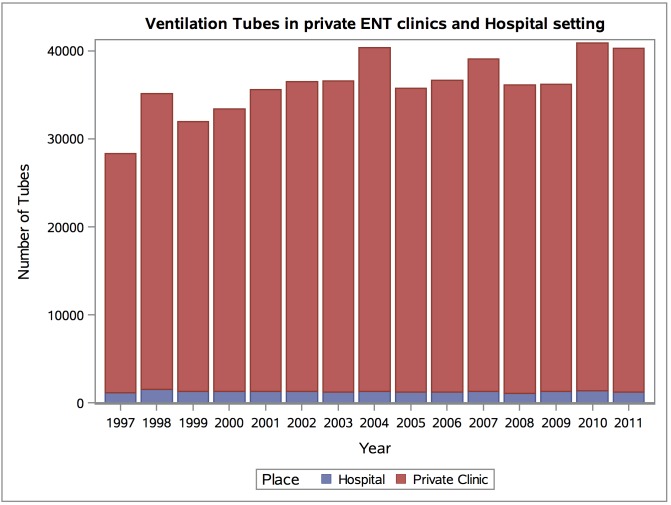
Number of ventilation tubes placed in private ENT-clinics compared to hospitals.